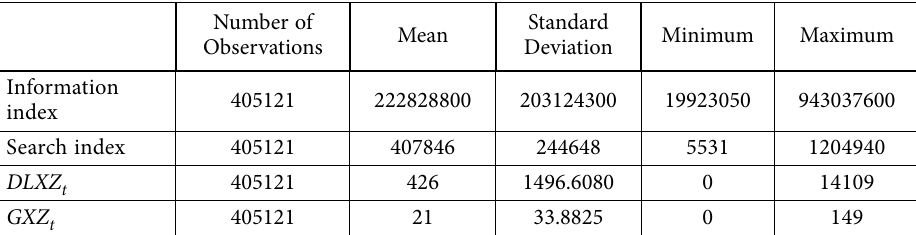
Table 3. Descriptive statistics of